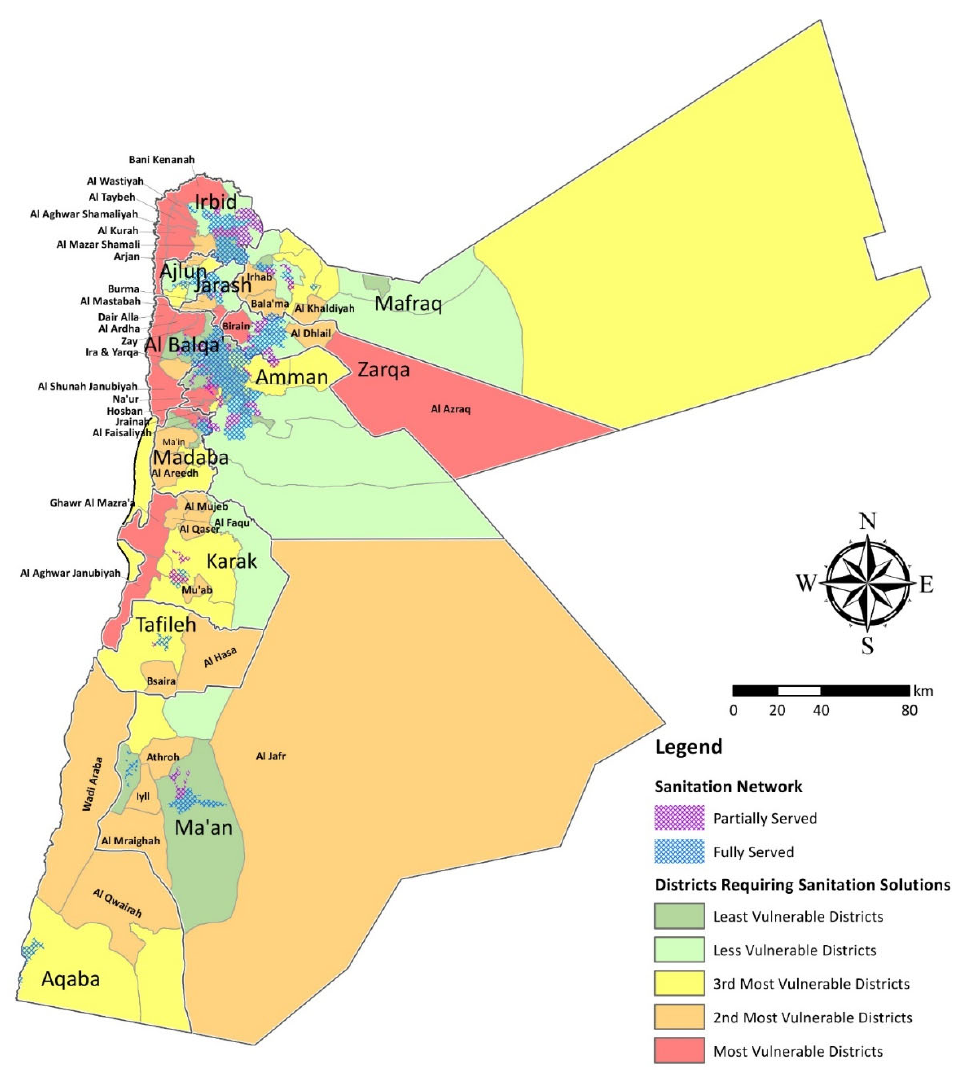
Figure 11. District ‐ scale Sanitation Hotspot Map. Figure 11. District-scale Sanitation Hotspot